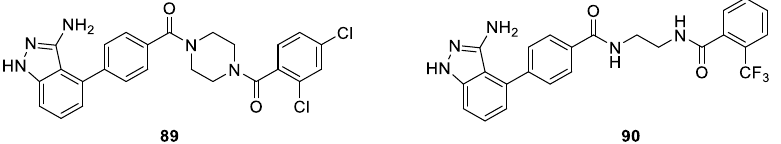
Figure 9. Chemical structures of 1 H -indazol-3-amine derivatives 89 and 90.